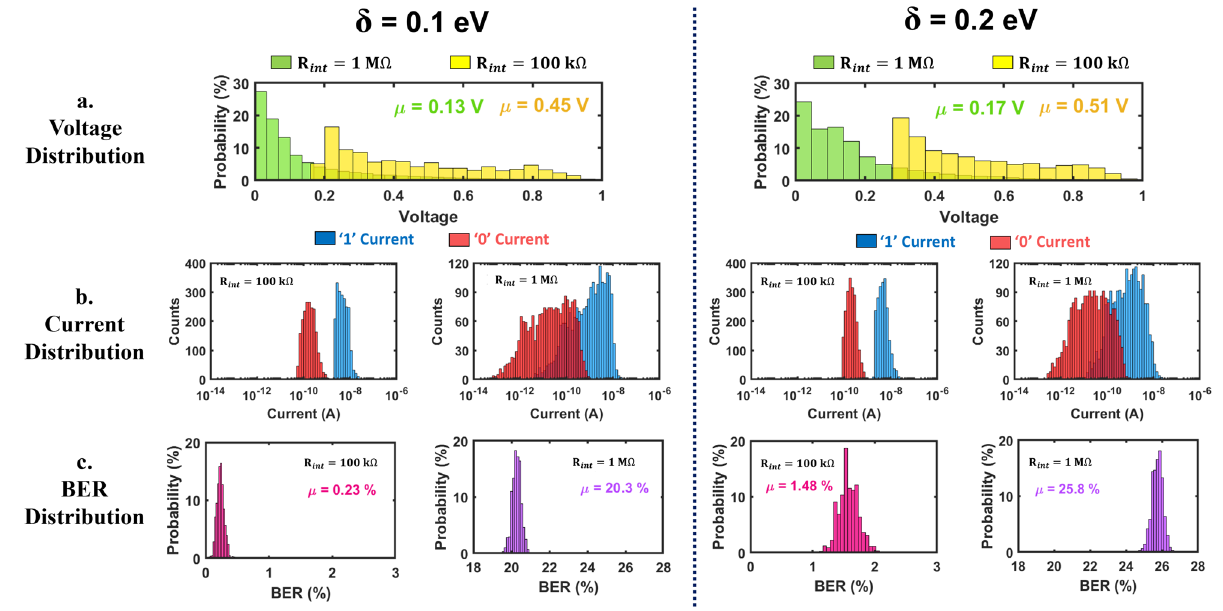
Figure 7. Monte Carlo simulation results for a 64 × 64 array: ( a ) voltage distributions, (b) current distributions, ( c ) bit error rate (BER) distributions for low ( δ = 0.1 eV) and high ( δ = 0.2 eV) Fermi energy variations. All results (including the means) are computed from 1000 Monte Carlo